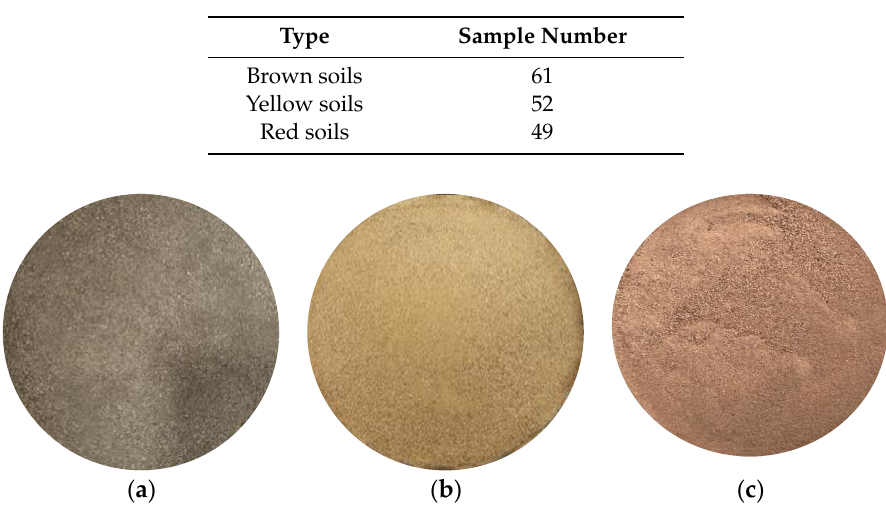
Table 1. Types of soil samples.